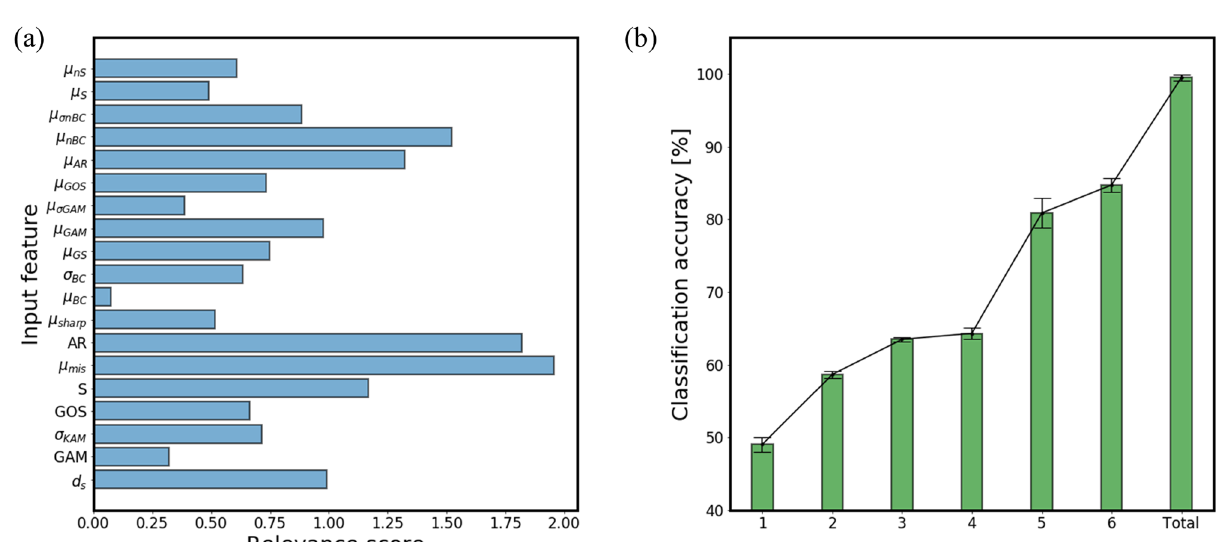
Figure 11. ( a ) Relevance score bar chart of input features of Steel D. ( b ) Comparison of scenarios where ‘Total’ keeps the entire features while the numbers (1–6) in the x-axis represent the number of high-scoring features utilized for phase